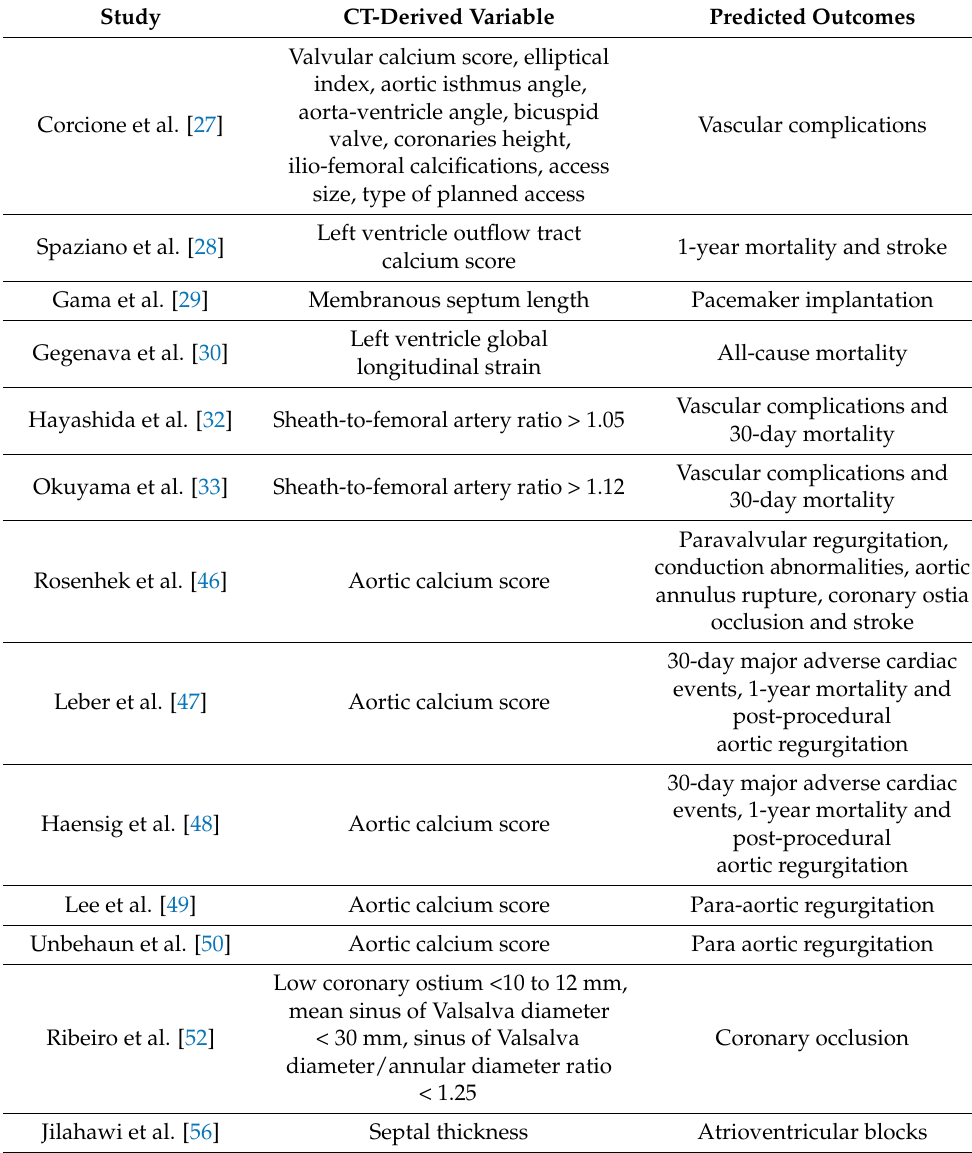
Table 1. Main studies investigating the predictive role of CT-derived variables on related